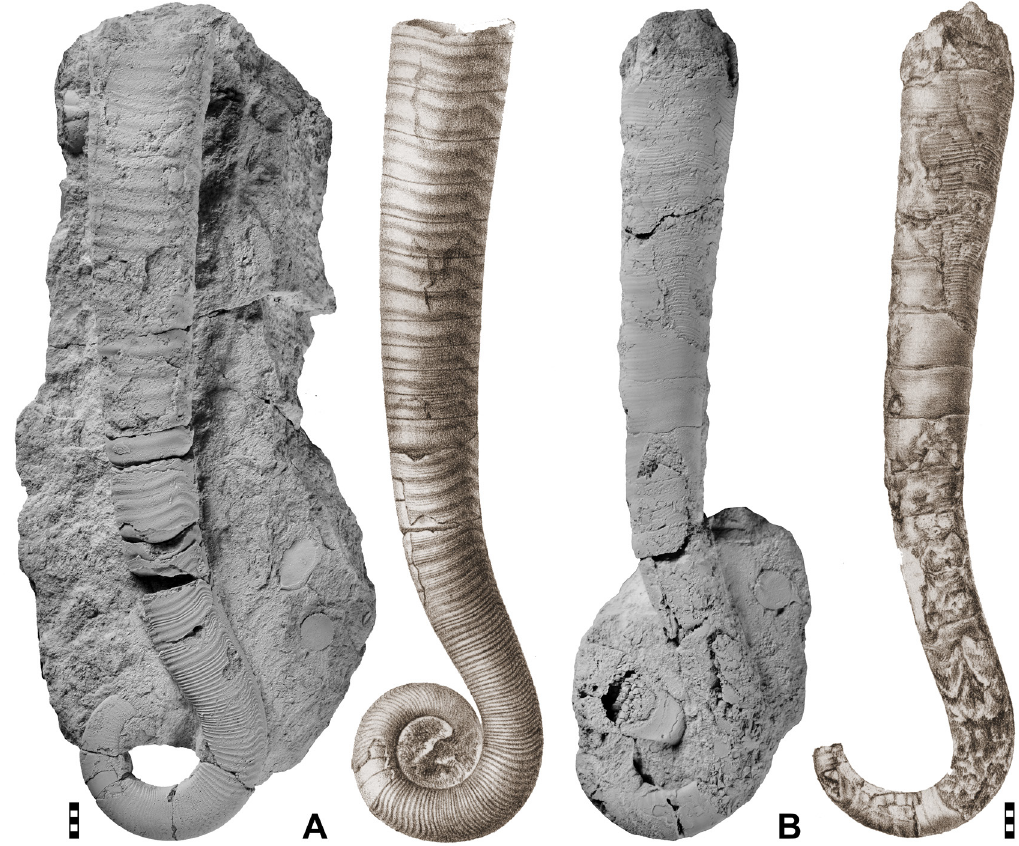
Fig. 45. Lituites lasaulxii Remelé, 1890 from the Upper Grey Orthoceratite Limestone. A . Lectotype MB.C.11678 (Kgl. Forstakademie Eberswalde Coll.) from Heegermühle (Brandenburg); photograph and reproduction of the illustration by Remelé (1890: pl. 3 fig. 1). B . Specimen MB.C.11645 (Remelé Coll.) from Eberswalde (Brandenburg); photograph and reproduction of the illustration by Remelé (1890: pl. 6 fig. 4). Scale bar units = 1